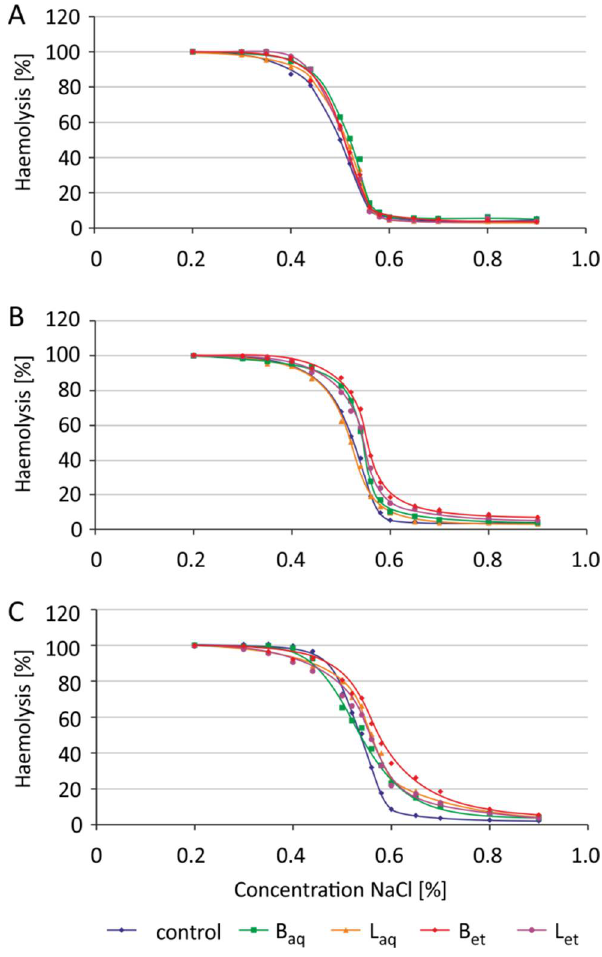
Figure 3. Changes in osmotic resistance of human erythrocytes incubated with U. tomentosa extracts at a concentration of 100 µ g/mL for 2 h ( A ), 5 h ( B ) and 24 h ( C ) (abbreviations as in Figure